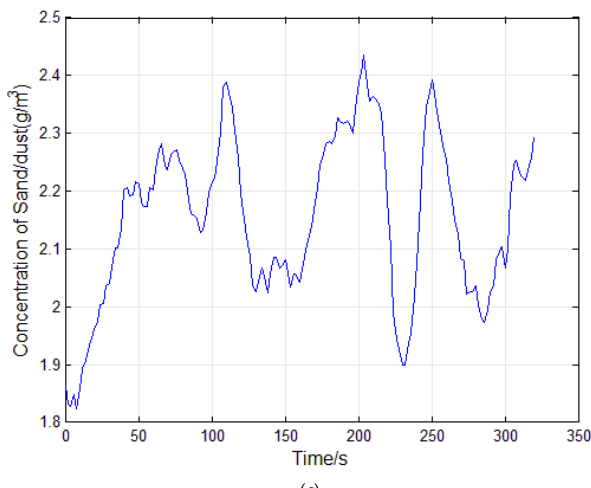
Figure 14. ( a ) Temperature variation of the test section in the high sand environment; ( b ) wind speed of the test section in the high sand environment; ( c ) sand concentration of the test section in the high sand environment.